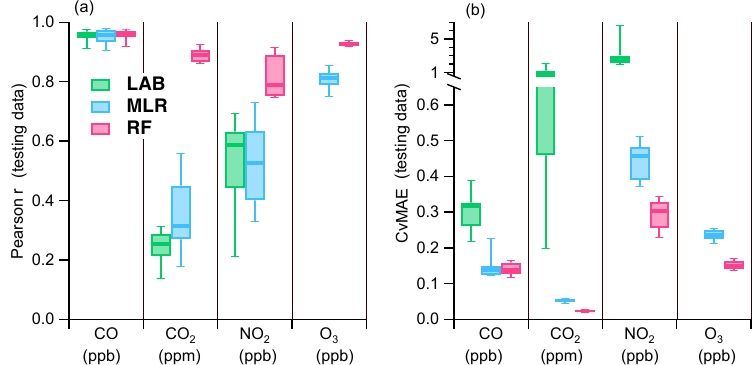
Figure 6. Performance of different calibration models against reference monitor testing data (data not included in model fitting). (a) Pearson r correlation coefficient (higher is better, maximum of 1) of different calibration models (“LAB”, green; “MLR”, blue; “RF”, pink) versus reference monitor. (b) The CvMAE (coefficient of variation of the MAE; MAE normalized by average reference concentration; lower is better) for the three calibration methods. The box plots show the range across the 10–16 RAMP monitors (whiskers: 10th and 90th percentile; box edges: 25th and 75th